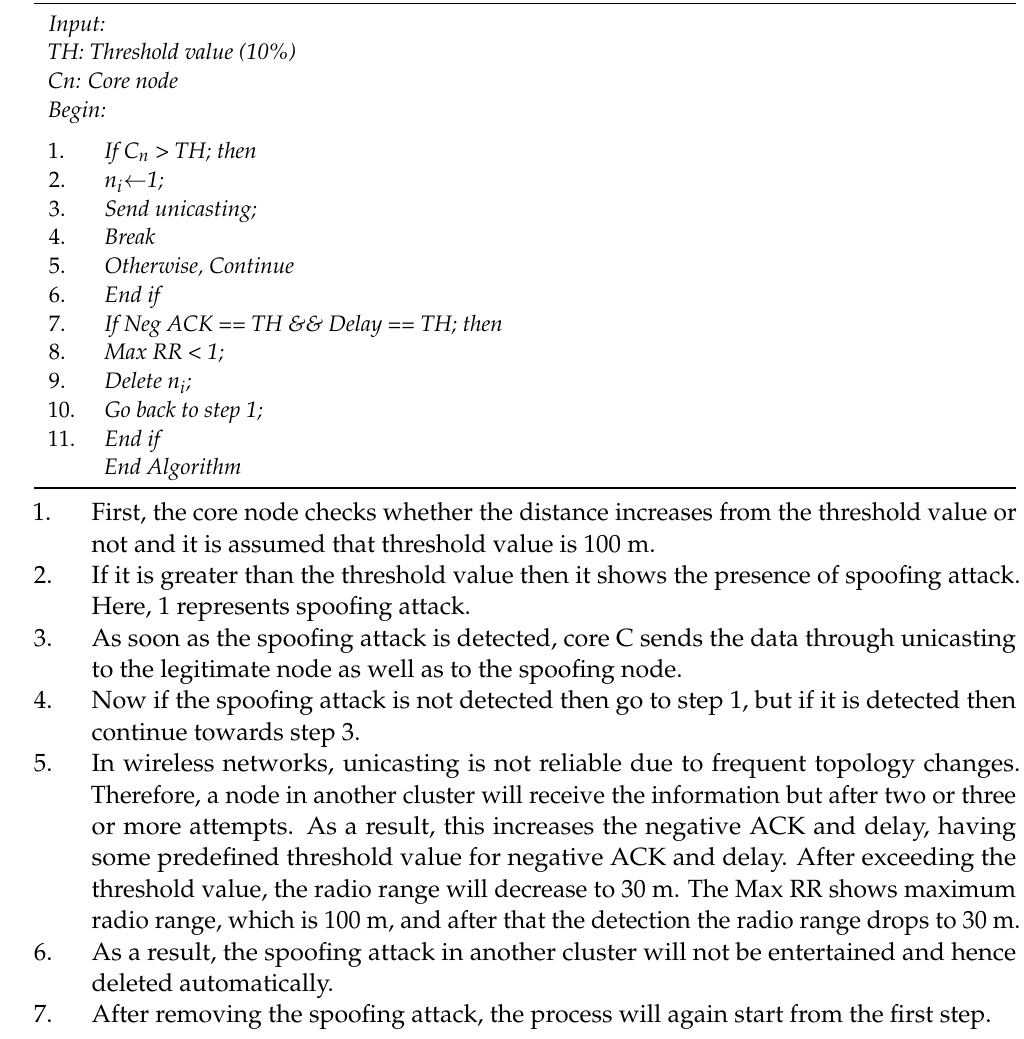
Algorithm 1. For the Detection, Identification and Removal of Spoofing